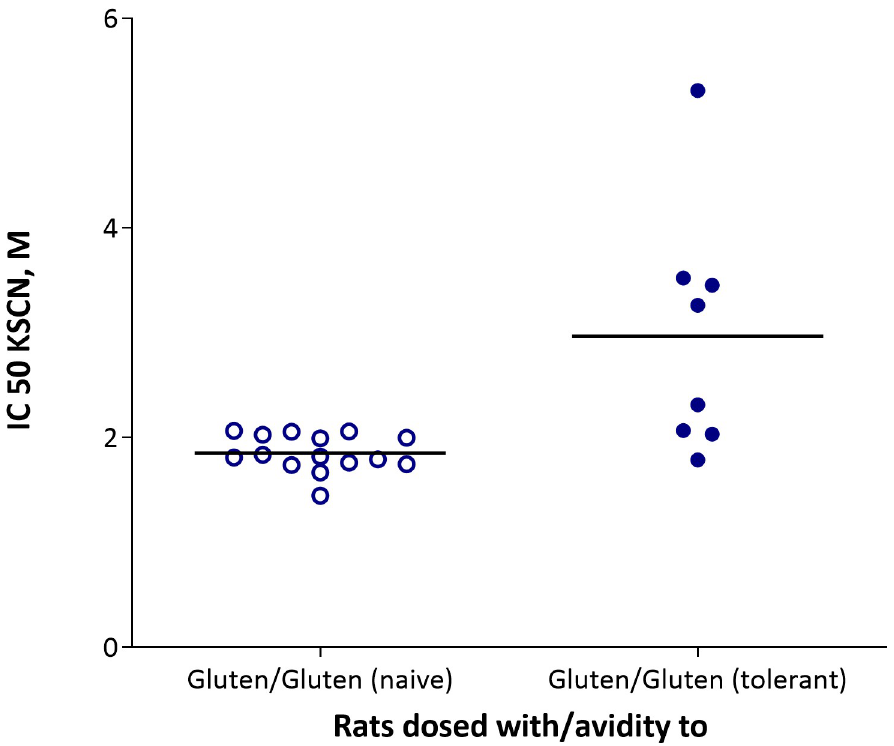
Fig 5. Avidity to gluten in na ï ve (open symbols) or gluten tolerant rats (closed symbols) immunized i.p. with gluten. The were no statistically significant differences.